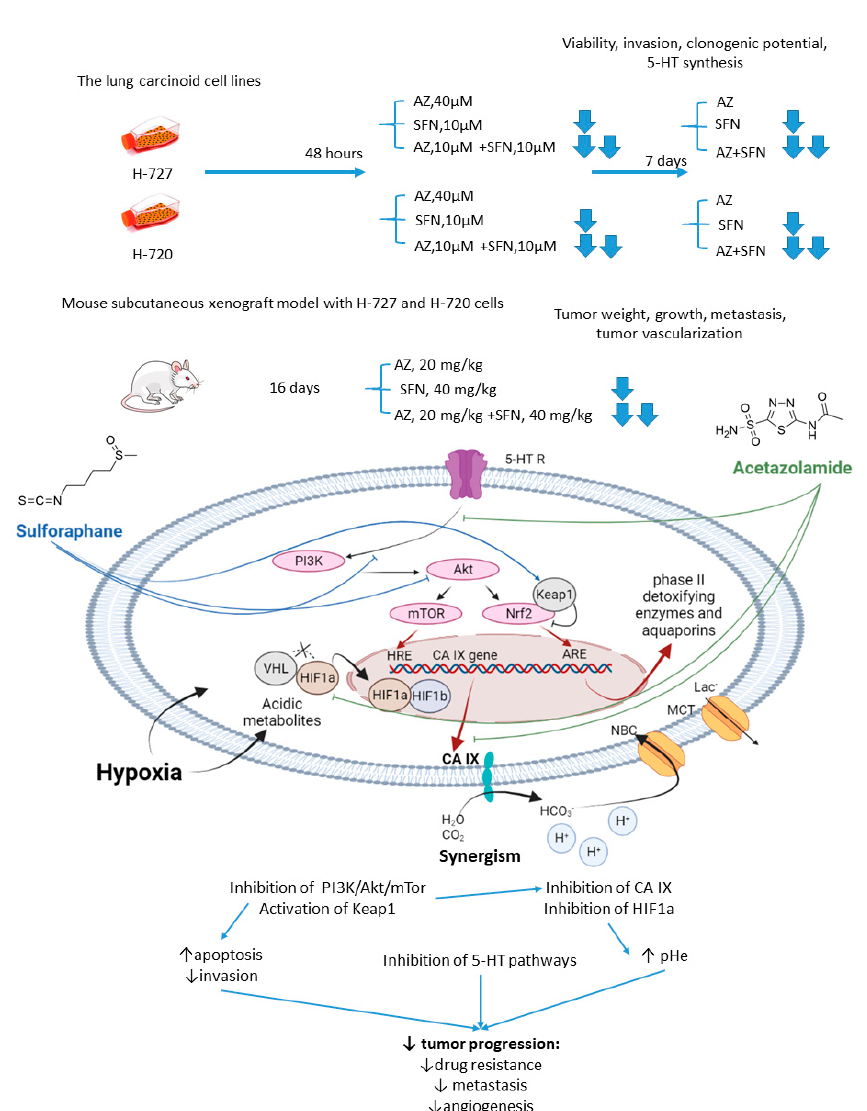
Figure 2. Graphical outline of the study on AZ+SFN combination reported by Mokhtari et al., and summary on the hypothesized molecular interactions resulting in synergistic action of the drugs [43,44].